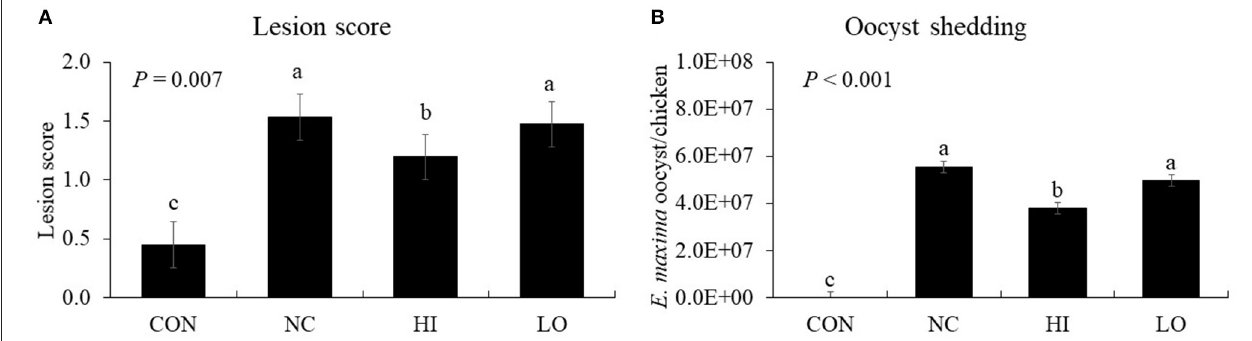
FIGURE 7 | Lesion score and oocyst shedding of chickens fed diet supplemented with maltol during infection with E. maxima . CON, basal diet; NC, basal diet for infected chickens; HI, maltol at 10.0 mg/kg feed; LO, maltol at 1.0 mg/kg feed; all chickens except CON were infected by oral gavage at day 14 with 1.0 × 10 4 oocysts/chicken of E. maxima. a − c Bars with no common letter differ significantly ( P < 0.05). Each bar represents the mean ± SEM ( n = 4). The lesion score was collected from distal jejunal tissue at day 20 (6 days post-infection: dpi) and fecal sample was collected from 6 to 8 dpi to calculate the oocyst